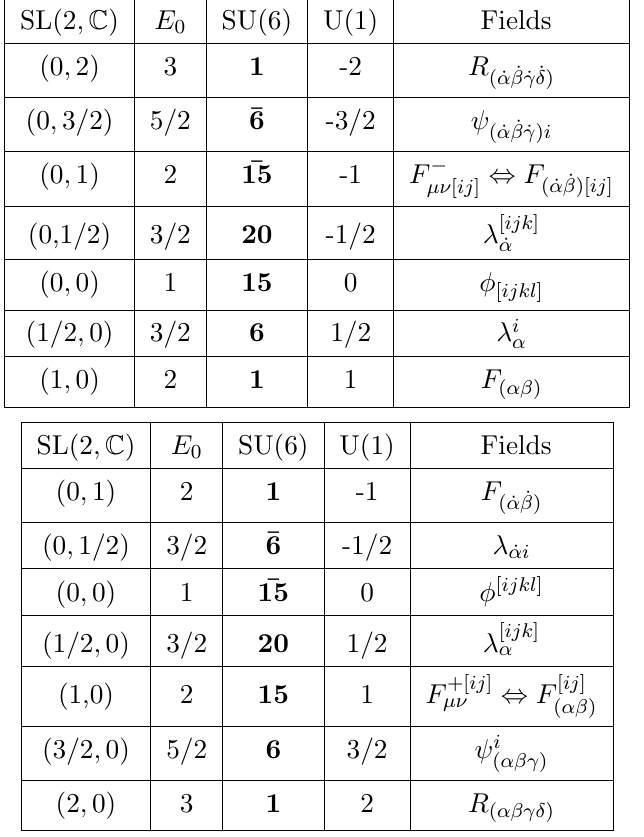
Table 2 . The irreducible chiral doubleton supermultiplet of SU(2 ; 2 j 6) and its conjugate, with the highest spin 2 corresponding to the (cid:12)elds of N = 6